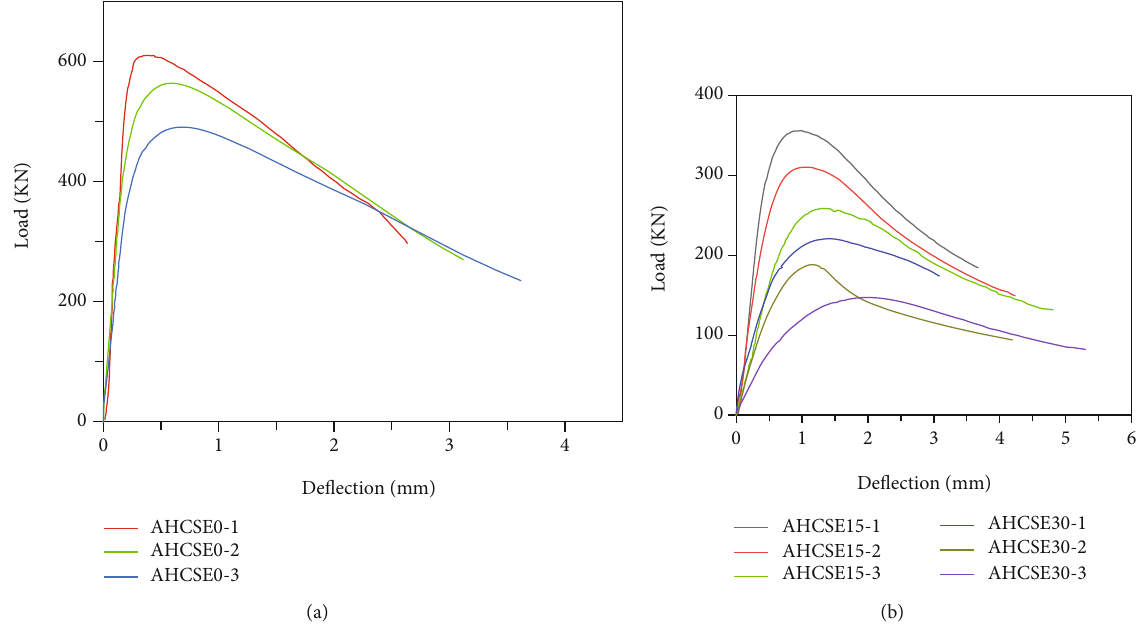
Figure 5: Specimen load de fl ection curve: (a) axial compression specimen; (b) eccentric compression